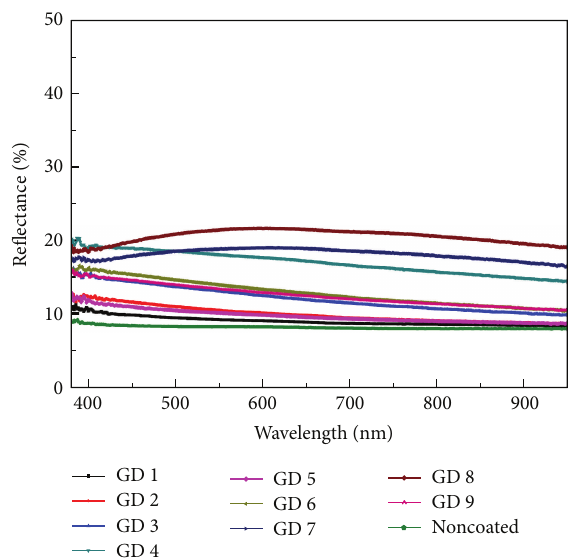
Figure 8: The various average reflectance of DLC films deposited by RF magnetron sputtering onto D263T